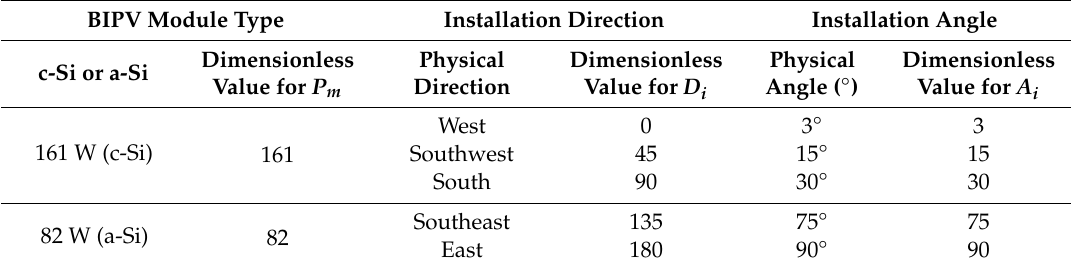
Table 8. Mapping table to select the input values to be used in Equation (2) for di ff erent design elements. BIPV Module